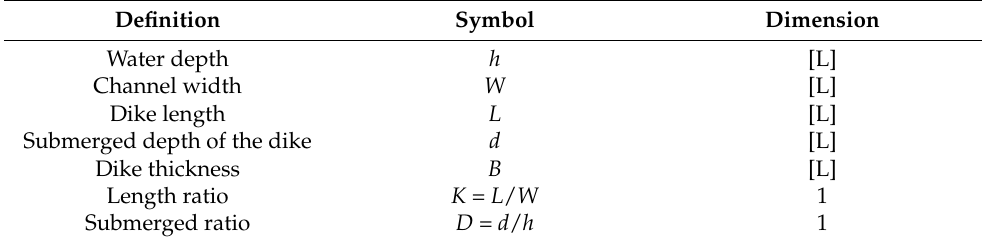
Table 2. Summary of experimental cases 1–8.